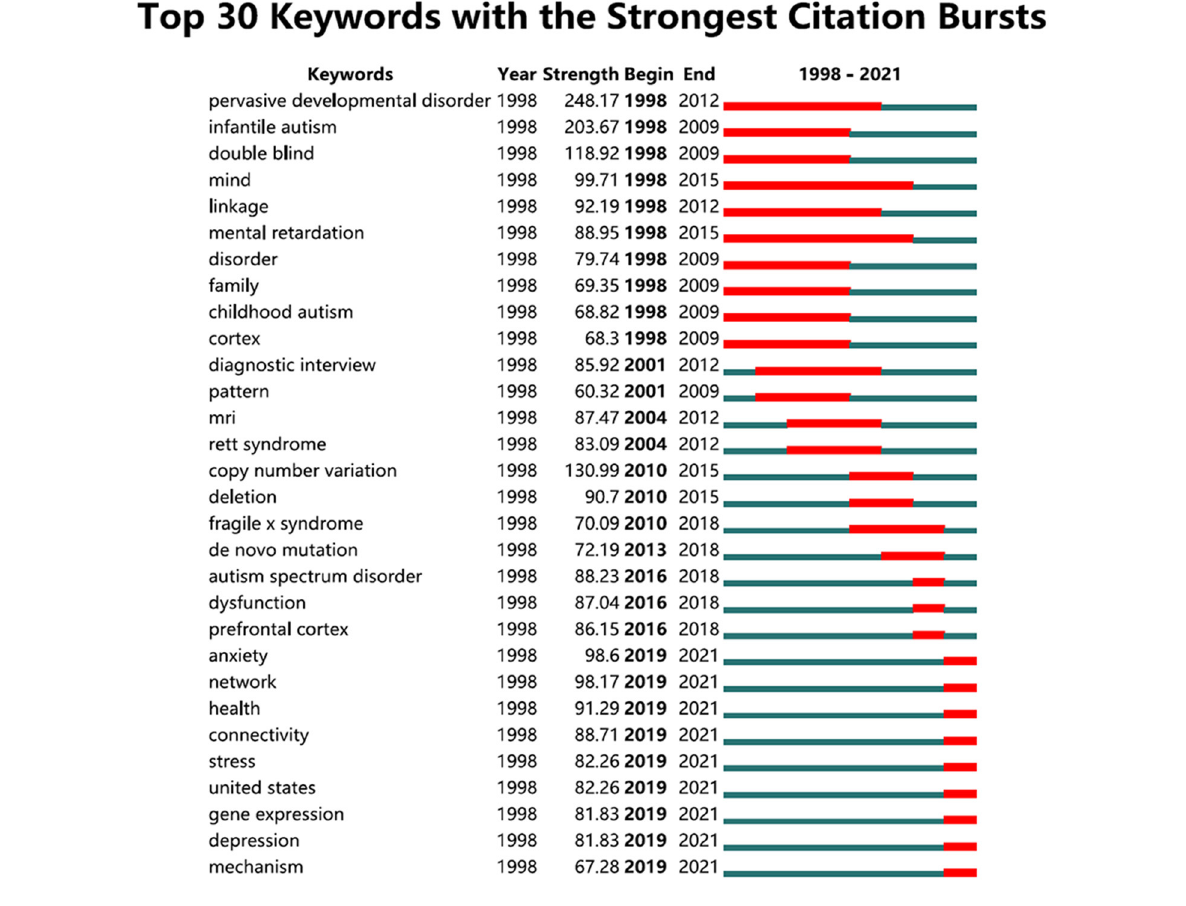
FIGURE6 Top 30 keywords with the strongest citation